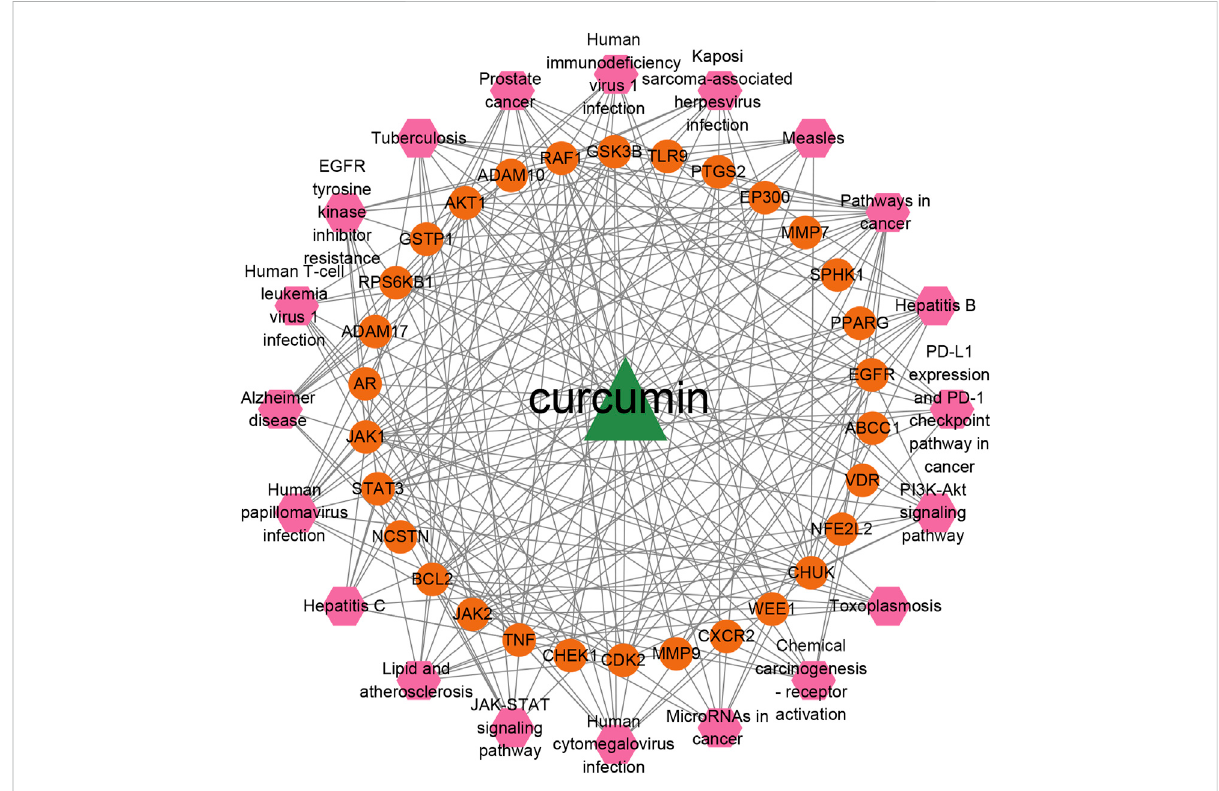
FIGURE 5 The network of the top 20 pathways and corresponded targets of CUR against